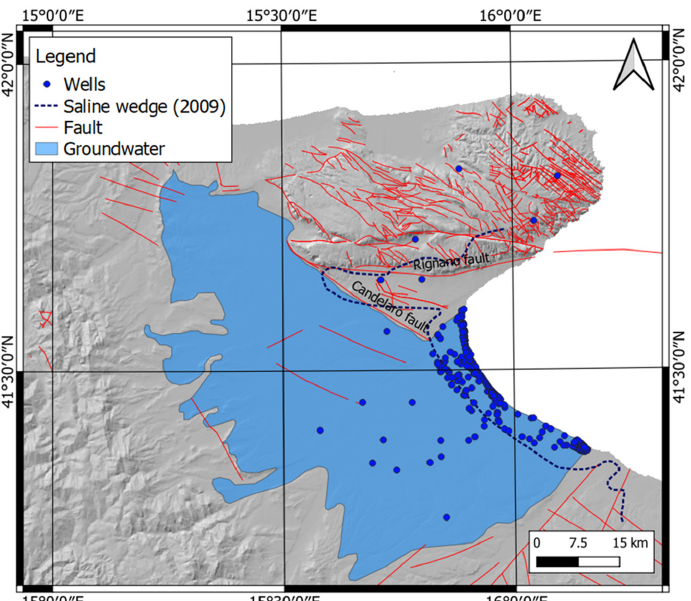
Figure 2. Sketch of Tavoliere hydrogeological districts, showing the low-quality groundwater with salt contamination (data from Apulia Region, 1984 [51]). Wells data are property of Apulia Region, Agenzia Regionale per la Prevenzione e la Protezione dell’Ambiente (ARPA) and Istituto Superiore per la Ricerca e Protezione Ambientale (ISPRA).